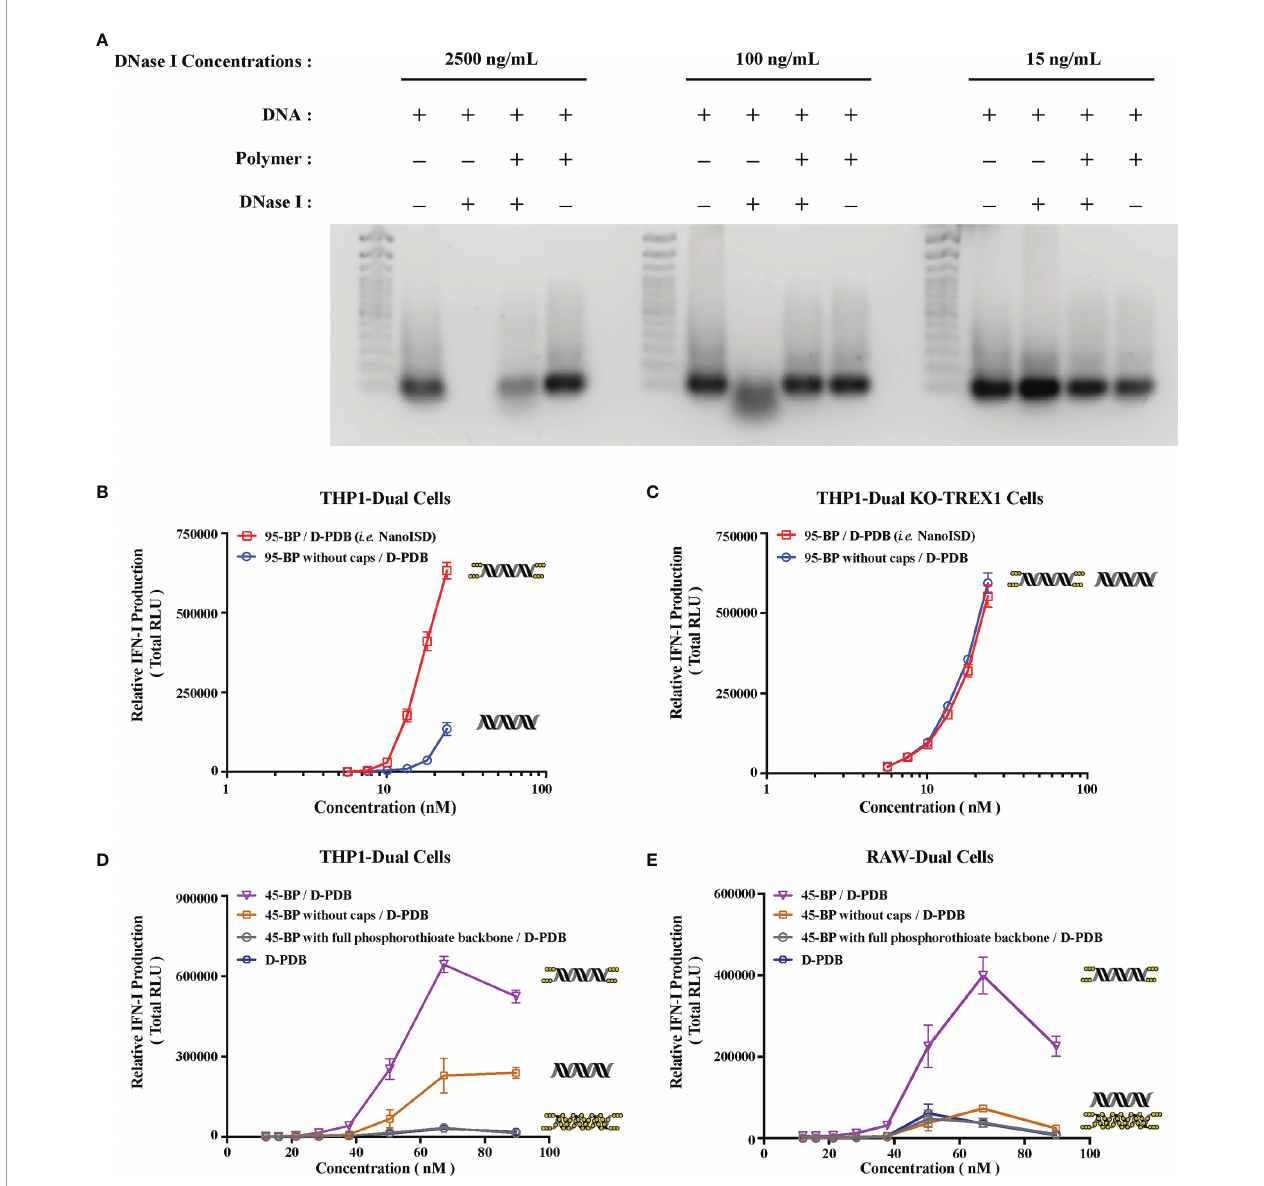
FIGURE 3 | NanoISD Exhibits Deoxyribonuclease Resistance. (A) Agarose gel image. Lanes are as indicated. The TrackIt ™ 100 bp DNA Ladder was used for reference. The DNA used in these studies was the phosphorothioate-capped 95-BP dsDNA at a concentration of 1 µg DNA/lane, and the polymer used was D-PDB at an N/P charge ratio of 4. (B) THP1-Dual reporter cell assay of 95-BP dsDNA with and without phosphorothioate caps complexed to D-PDB at an N/P charge ratio of 4. (C) THP1-Dual KO-TREX1 reporter cell assay of 95-BP dsDNA with and without phosphorothioate caps complexed to D-PDB at an N/P charge ratio of 4. (D) THP1-Dual reporter cell assay of synthetic 45-BP dsDNA complexed to D-PDB at an N/P charge ratio of 4, and D-PDB was used as an experimental control. Each 45-BP/D-PDB treatment comprised DNA with varying levels of phosphorothioate incorporation as indicated. (E) RAW-Dual reporter cell assay of synthetic 45- BP dsDNA complexed to D-PDB at an N/P charge ratio of 4, and D-PDB was used as an experimental control. Each 45-BP/D-PDB treatment comprised DNA with varying levels of phosphorothioate incorporation as indicated. The dose response curves for free D-PDB are positioned along the x-axis corresponding to their equivalent dsDNA-loaded treatments, as each dose response that utilized the polymer was administered using equivalent D-PDB